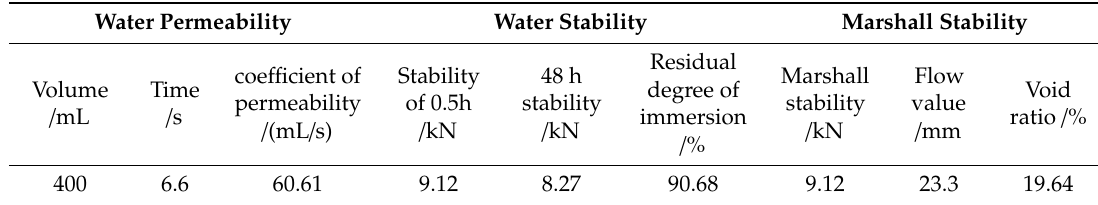
Table 1. Test results of the permeability, water stability, and Marshall stability.